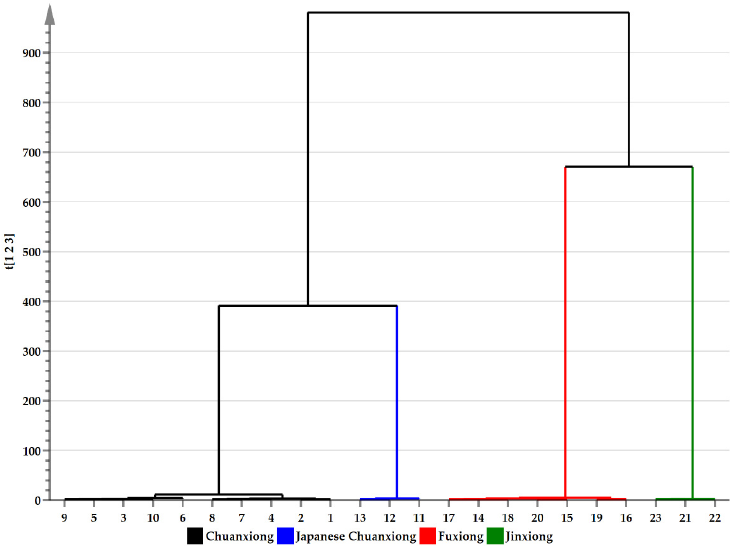
Figure 3. The hierarchical clustering analysis (HCA) of the four herbs. 1–10: Chuanxiong ( Ligusticum chuanxiong ); 11–13: Japanese Chuanxiong ( Cnidium officinale ); 14–20: Fuxiong ( Ligusticum